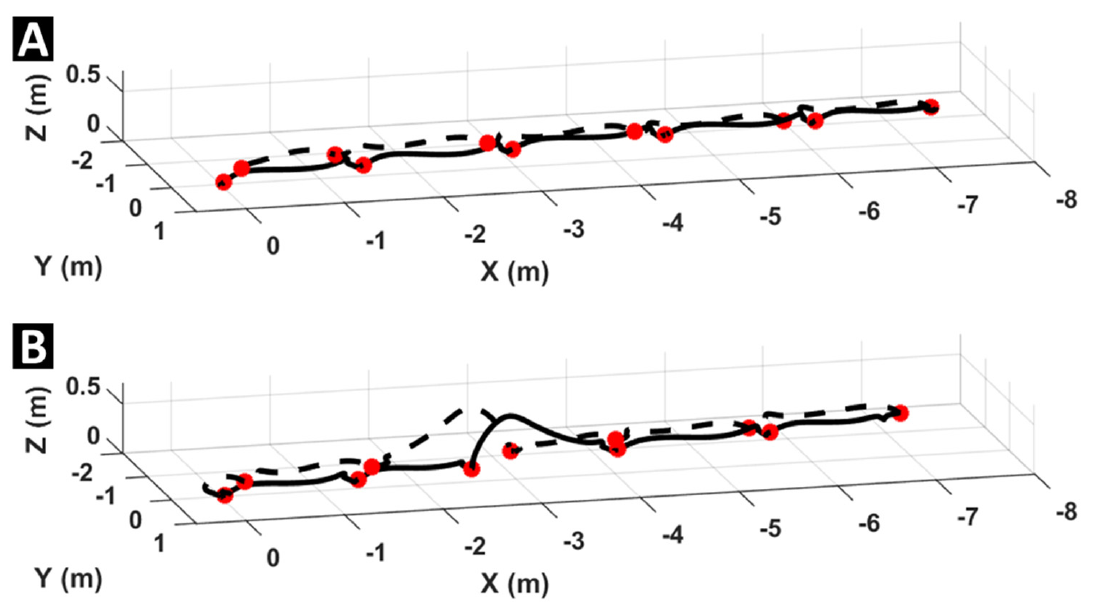
Figure 3. Step trajectories from one foot during the walk and turn task ( A ) and the walk and turn with obstacle task ( B ) from a representative participant from the MS group. Toe-off timepoints are indicted with red dots and dashed lines indicate trajectories following the turn in each task.